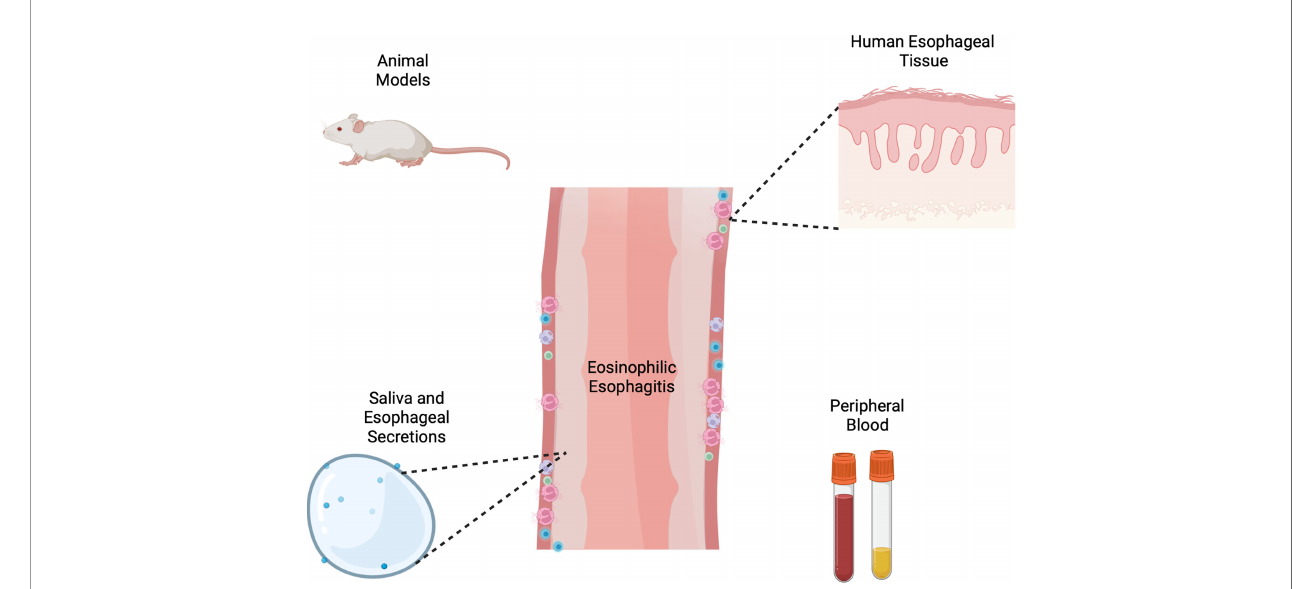
FIGURE 1 | Schema of varied tools and models for investigation of eosinophilic esophagitis including animal models, human esophageal cells and tissue, esophageal secretions and peripheral blood or serum. Created with